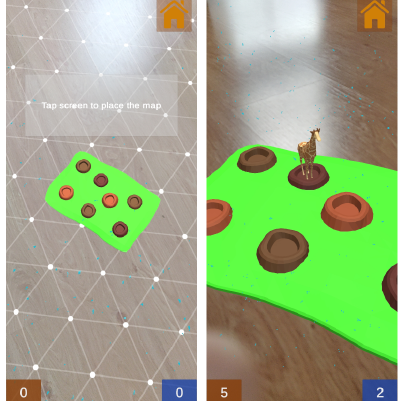
Figure 13. Screenshots from the Wakamole game: surface detection process ( left ) and during the game ( right